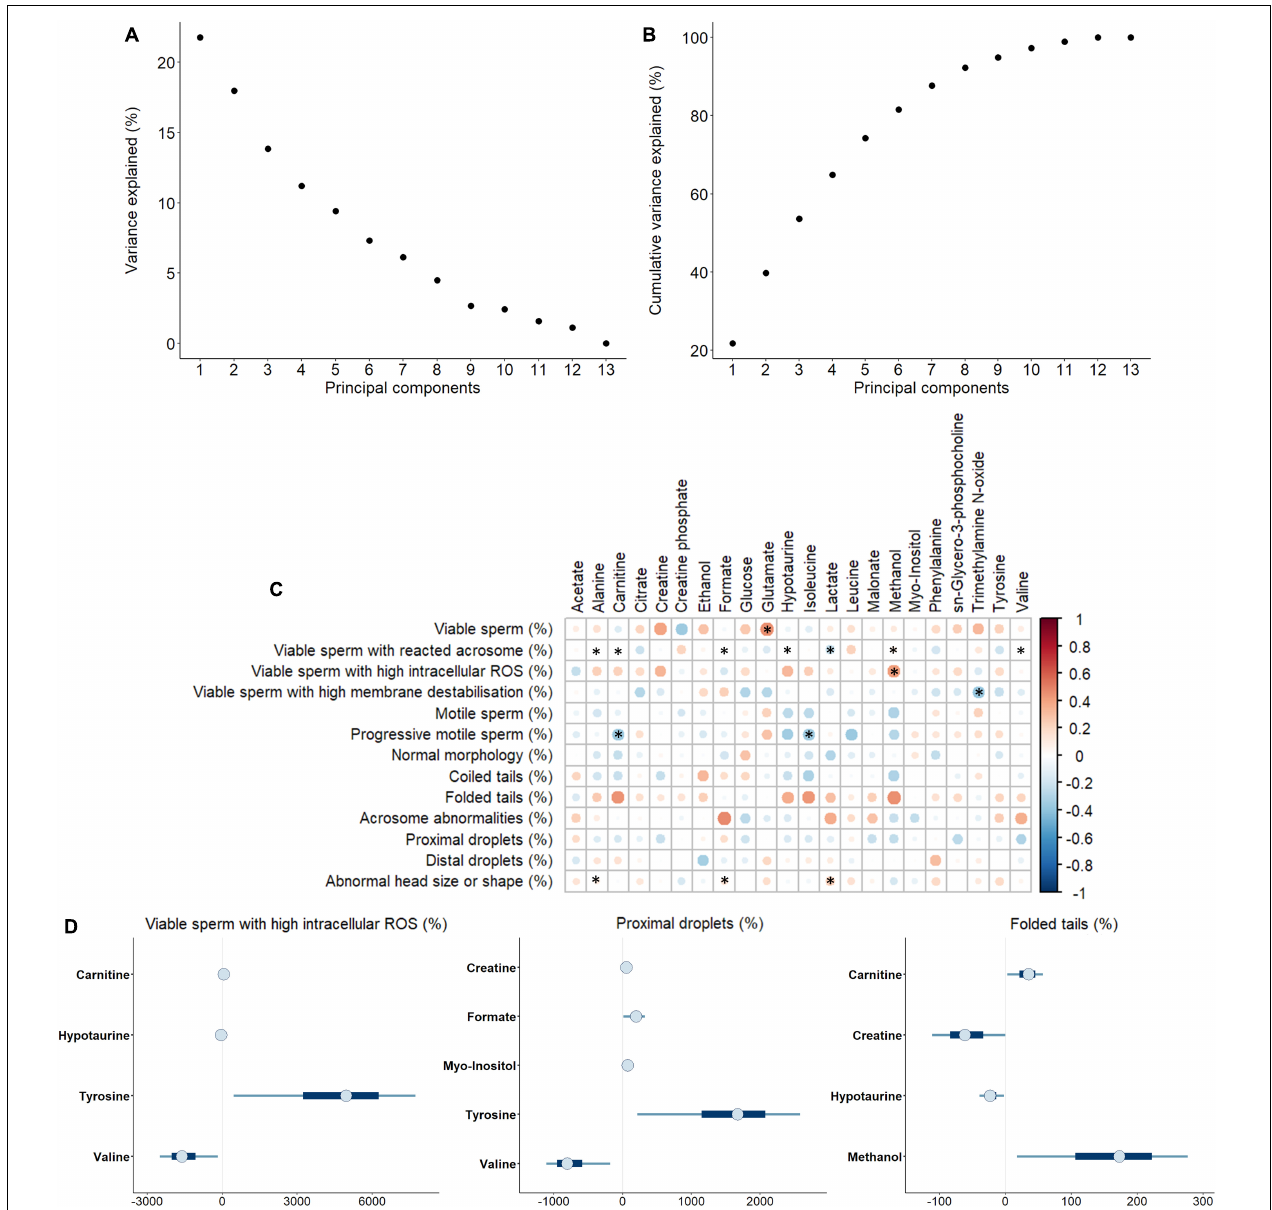
FIGURE 3 | (A) Variance explained by each principal component. (B) Cumulative variance explained by principal components. (C) Correlations between metabolites identified in pig seminal plasma and different sperm functionality parameters analyzed immediately after semen collection. The color saturation of red to blue represents the correlation coefficients (R) between metabolites, from 1 to -1, respectively. Significant correlations ( P < 0.05) are marked with *. (D) Bayesian multiple linear regression models for percentage of viable sperm with high intracellular reactive oxygen species, ROS (H 2 O 2 ), percentages of sperm with proximal droplets and percentages of sperm with folded tails. Thin lines represent the 90% credible intervals, and the blue box represents the 50% credible intervals. Dots represent the median estimated for each metabolite in the model.